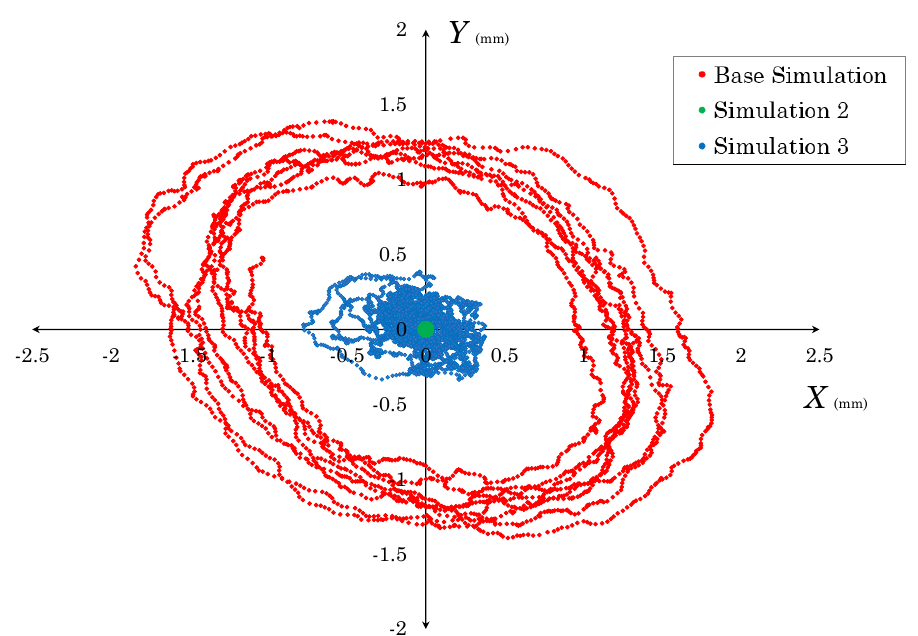
Figure 16. Position of the tip of the plug during the RTP